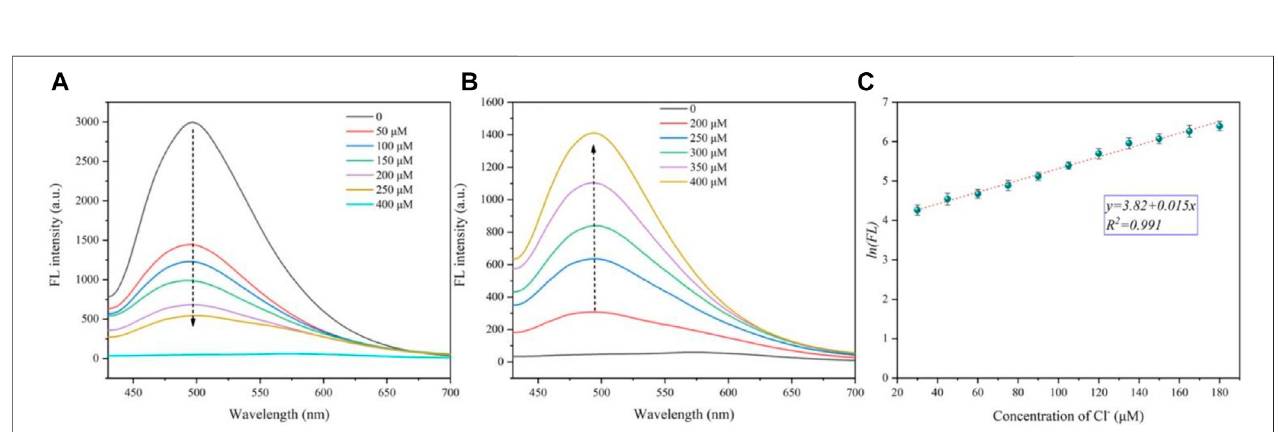
FIGURE 4 | (A) Fluorescence decrease curves of CDs (10 μ g/ml) with different Ag + concentrations (from 0 to 400 μ M). (B) Fluorescence recovery curves of CDs (10 μ g/ml) coating Ag + (400 μ M) with different Cl − concentrations (from 0 to 400 μ M). (C) Linear relationship between the natural logarithm of fl uorescence intensity and chloride